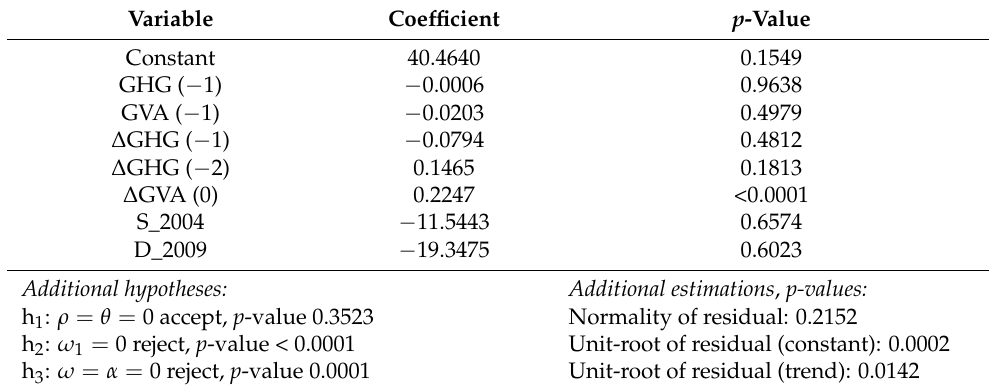
Table 7. Panel data (stacked time series) for all three countries’ ARDL